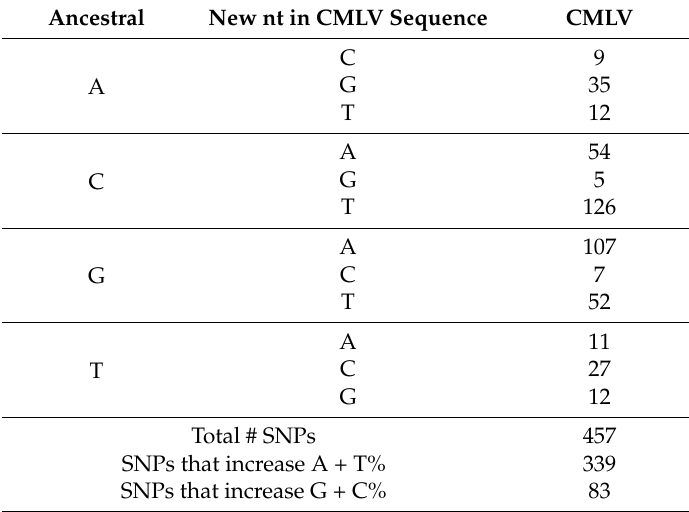
Table 3. Nucleotide changes for SNPs in CMLV compared to nucleotides identical in vaccinia virus (VACV), VARV, TATV, and